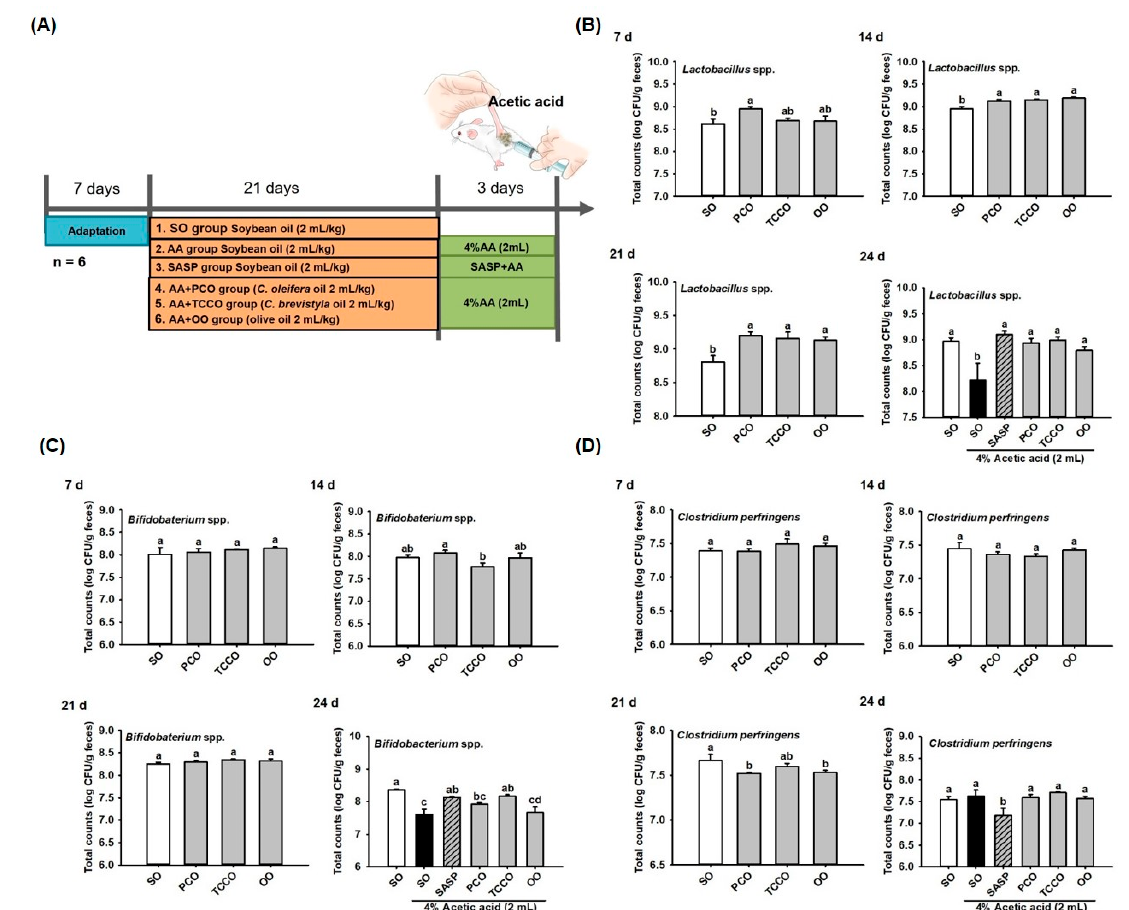
Figure 2. Effects of SO, PCO, TCCO, and OO on gut microbiota. ( A ) experimental groups, ( B ) Lactobacillus spp., ( C ) Bifidobacterium spp., and ( D ) Clostridium perfringens over 7, 14, 21, and 24 days in Sprague–Dawley rats. The rats received oral administrations of SO, PCO, TCCO, or OO for 3 weeks, and then, AA was administered intrarectally for colitis induction (except in the normal control group). SASP was used as a positive control after inducing colitis by using AA. The results are expressed as the mean ± standard error of the mean (SEM) ( n = 6). Values assigned different letters are significantly different at p < 0.05, which was determined using Duncan’s multiple range test. SO, 2 mL/kg body weight (BW) of soybean oil; AA, 2 mL of 4% of AA; SASP, 500 mg/kg BW of sulfasalazine; PCO, 2 mL/kg BW of C. oleifera oil; TCCO, 2 mL/kg BW of C. brevistyla oil; and OO, 2 mL/kg BW of olive oil.